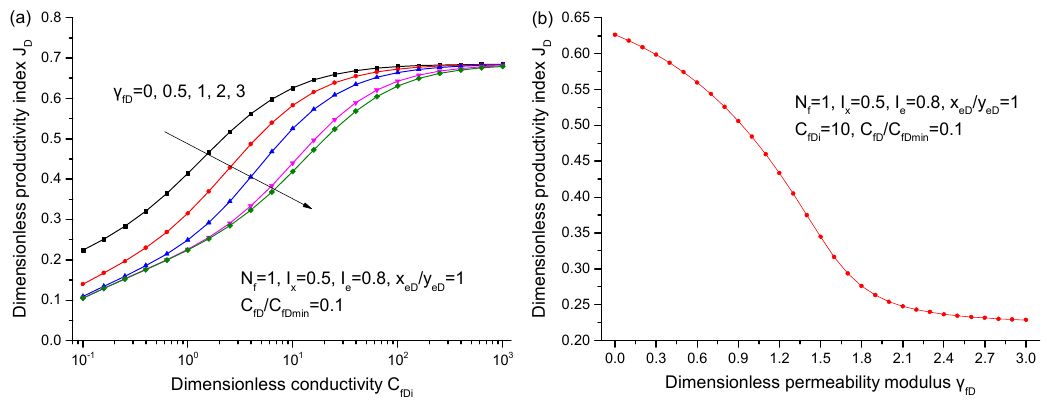
Figure 15. ( a ) Influence of fracture conductivity on PI behavior with the pressure-sensitivity effect, and ( b ) influence of permeability modulus on PI behavior with consideration of finite conductivity.